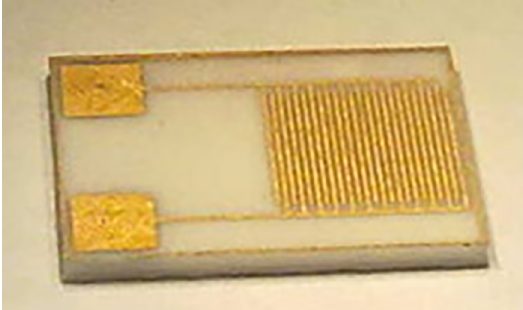
Figure 1. Schematics of a sensor substrate